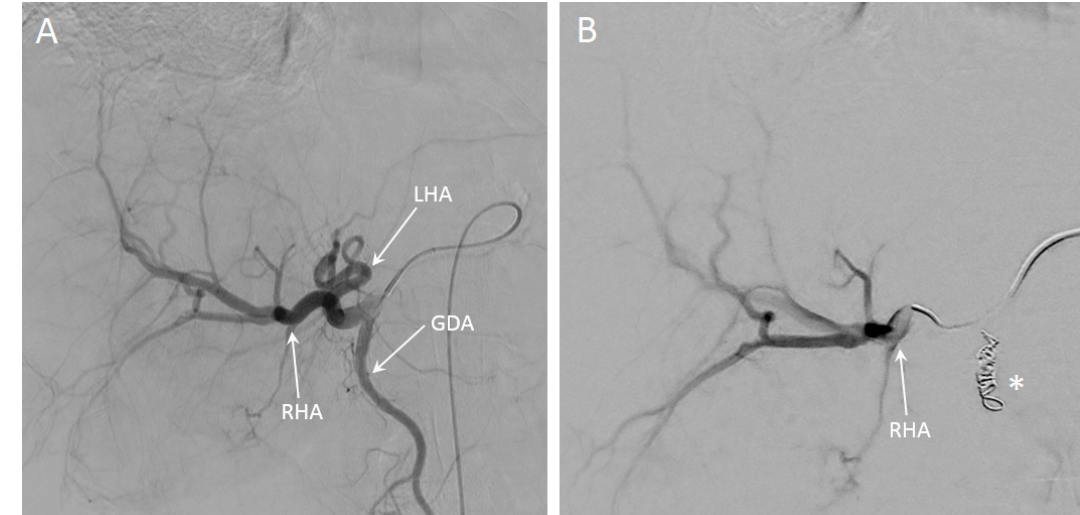
Figure 8. Overview angiography of the entire liver of a patient with intrahepatic cholangiocarcinoma ( A ), in which the left hepatic artery (LHA), right hepatic artery (RHA) and gastroduodenal artery (GDA) are visible. In ( B ), the RHA is selectively catheterized, after the GDA has been coiled (indicated with the asterisk).